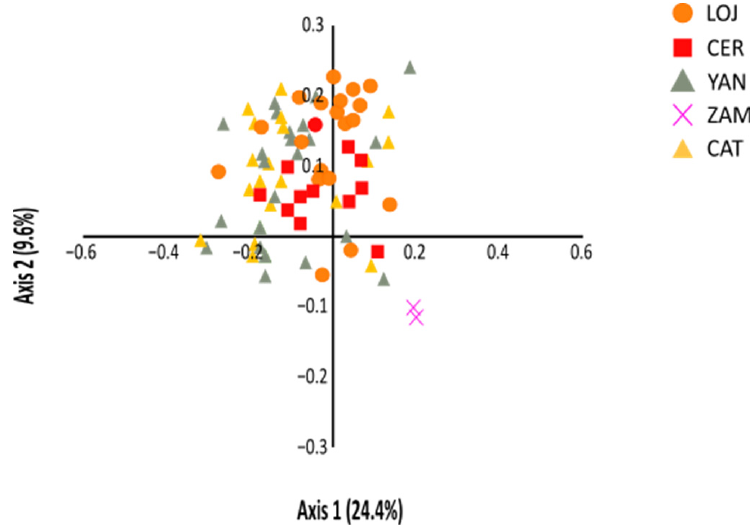
Figure 4. Genetic relationships between all Ocotea rotundata samples based on a principal coordinate analysis (PCoA). Note that only a small number of individuals can be seen in ZAM since most samples have identical alleles. Population labels refer to Table 2.